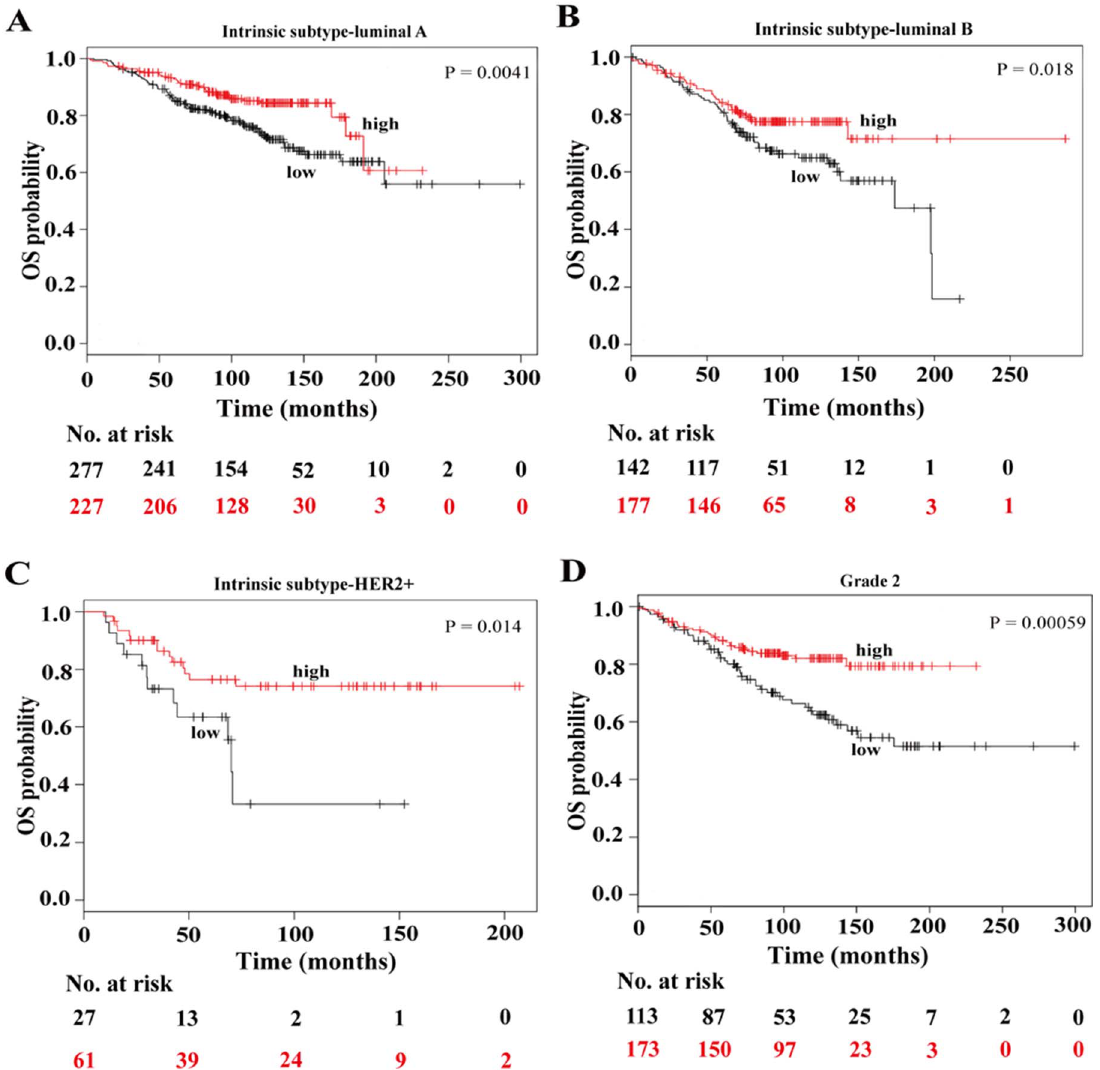
Figure 4. Low expression of C10orf10 is correlated with shorter survival in patients from KM plotter with luminal A, luminal B, Her2 + and grade 2 of the breast cancer. (A) Kaplan-Meir survival analysis of C10orf10 in 504 patients with luminal A tumors. Auto select best cutoff was chosen in the analysis; Cutoff value used was 1117; Expression range of the probe was 186–3881. (B) Kaplan-Meir survival analysis of C10orf10 in 319 patients with luminal B tumors. Auto select best cutoff was chosen in the analysis; Cutoff value used was 1052; Expression range of the probe was 181–3158. (C) Kaplan-Meir survival analysis of C10orf10 in 88 patients with Her2 + tumors. Auto select best cutoff was chosen in the analysis; Cutoff value used was 655; Expression range of the probe was 153–3475. (D) Survival analysis of C10orf10 expression in 286 patients with grade 2 of the breast cancer. Auto select best cutoff was chosen in the analysis; Cutoff value used was 1117; Expression range of the probe was 143–